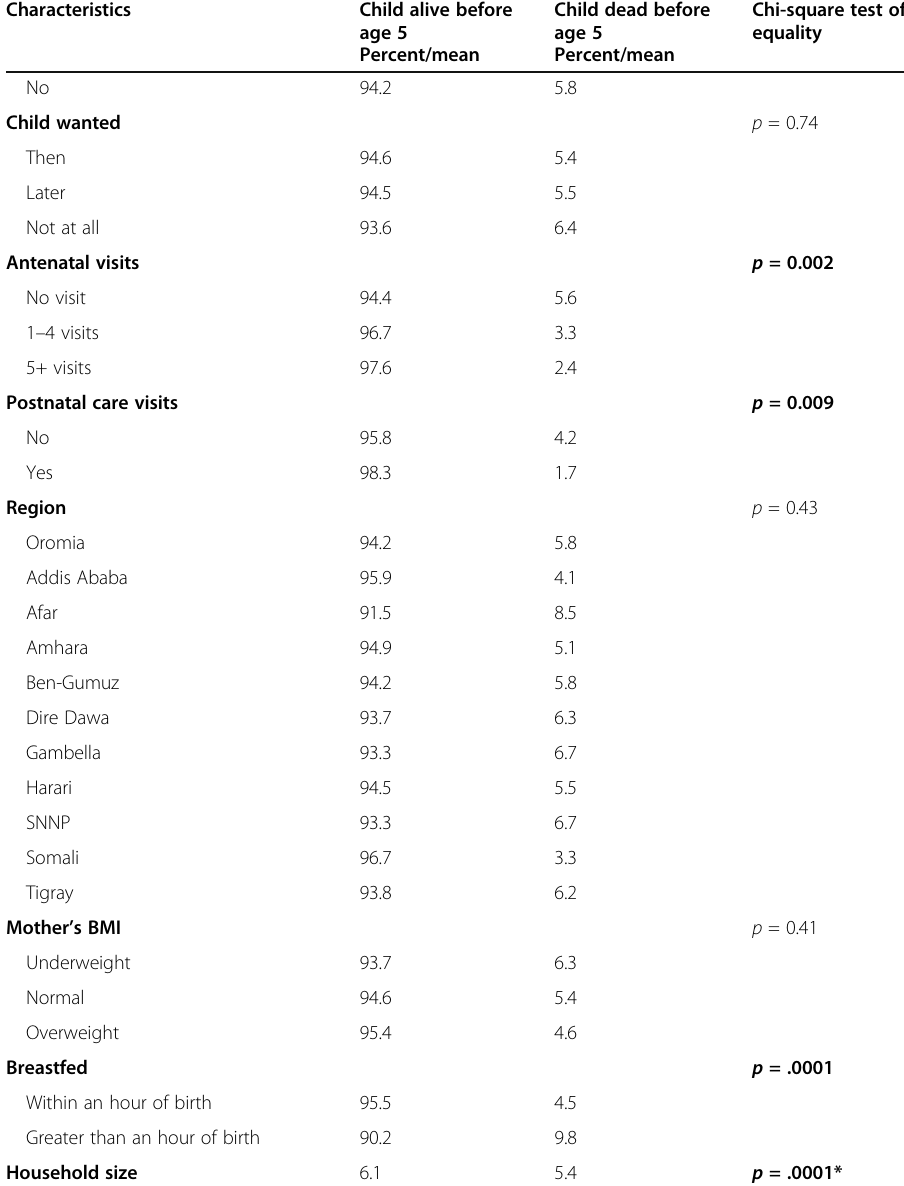
Table 1 Descriptive statistics of child mortality outcome by study characteristics, EDHS 2016 ( N = 10,641)